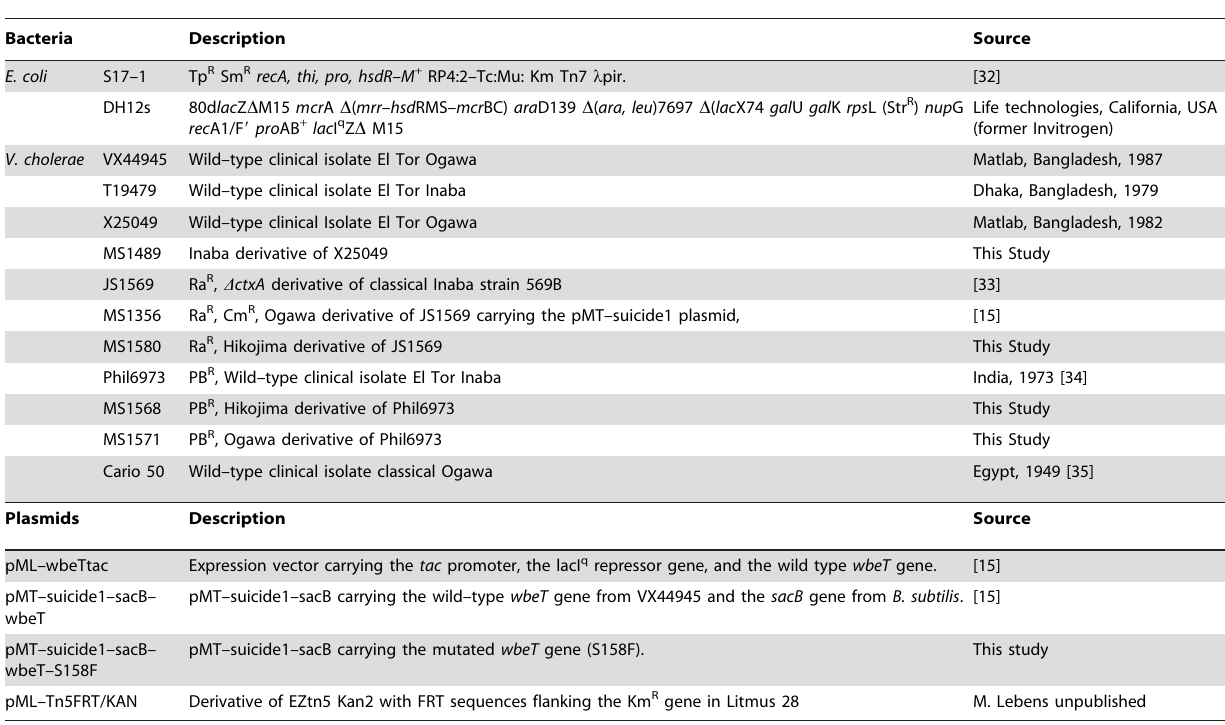
Table 2. Bacterial strains and plasmids used in the current study.